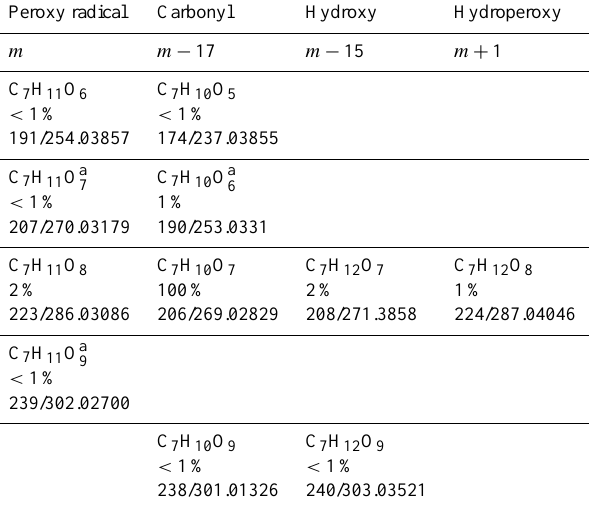
Table 8. HOM observed during ozonolysis of 1- Table 9. HOM products observed during ozonolysis of 3- methylcyclohexene. The second header line shows at which methylcyclohexene. The second header line shows at which molar molar masses the termination products are expected relative to masses the termination products are expected relative to the peroxy the peroxy radical with molar mass m (unit masses). Filled cells radical with molar mass m (unit masses). Filled cells indicate that indicate that these compounds were detected with given elemental these compounds were detected with given elemental composition composition and relative intensity (second line in the same cell). and relative intensity (second line in the same cell). Relative inten- Relative intensities were normalized to the largest HOM signal. sities were normalized to the largest HOM signal. The third line in The third line in the cell gives the molar mass [Da] in unit mass the cell gives the molar mass [Da] in unit mass resolution and the resolution and the precise m/z [Th] at which the molecule was precise m/z [Th] at which the molecule was detected as cluster with 15 NO − detected as cluster with 15 NO − . . 3 3 Peroxy radical Carbonyl